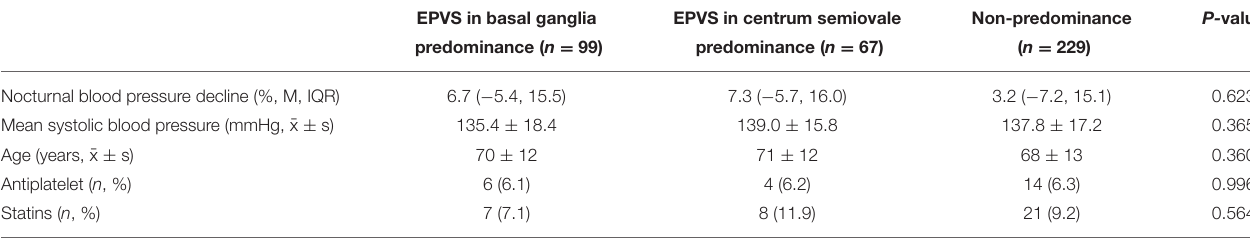
TABLE 6 | The comparison of independent factors among predominance types of